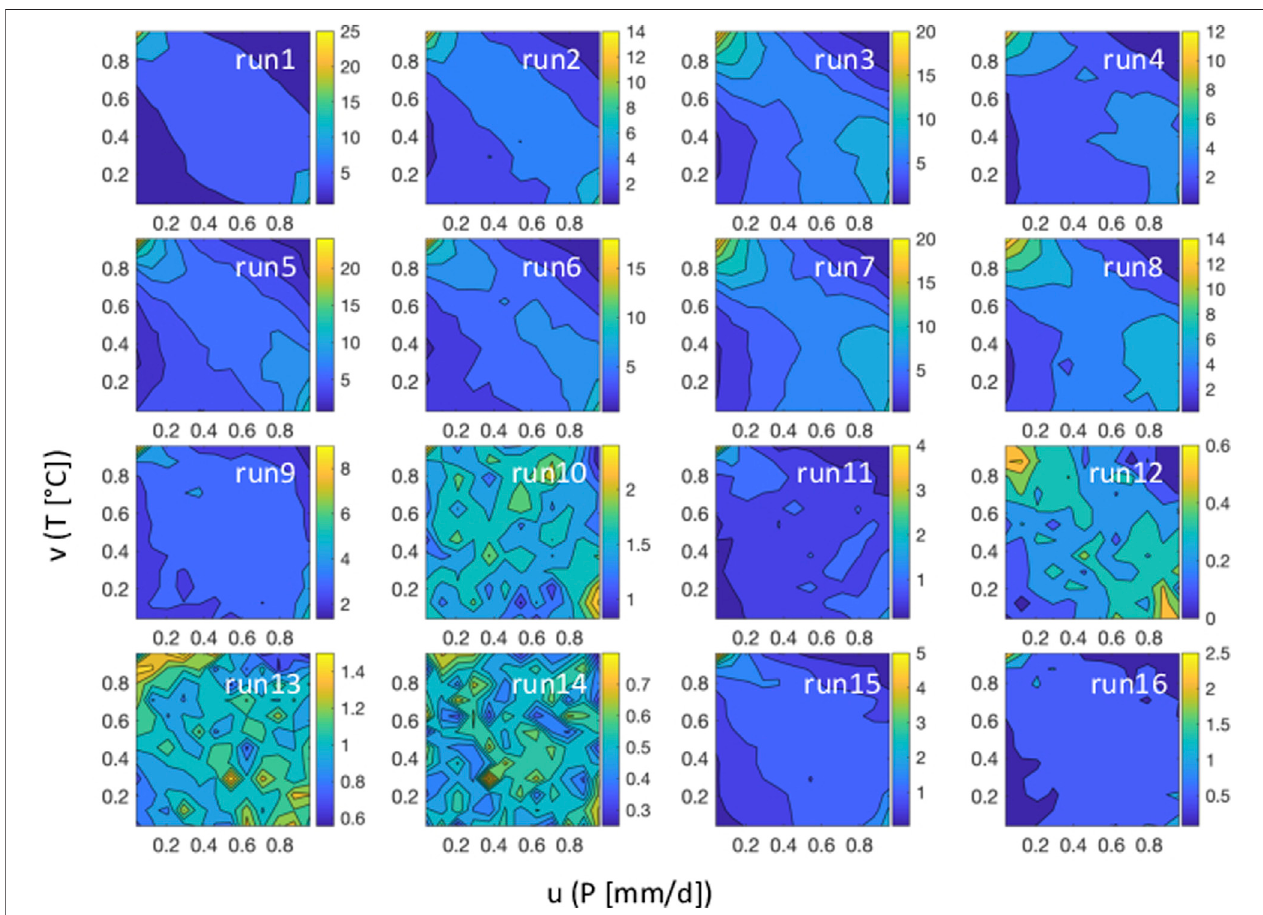
FIGURE8| EmpiricalCopulawithjointPandTpairsfromthe16WRFsimulationsatlocationsfromtheincludedPandTpairsfromGHCN-Ddataduringtheperiod 2006 – 2010.See Figure1 forobservationstations included inthisanalysis.Note thattheCopuladensitieshave differentscalingforbettervisibilityofthedensity shapes.